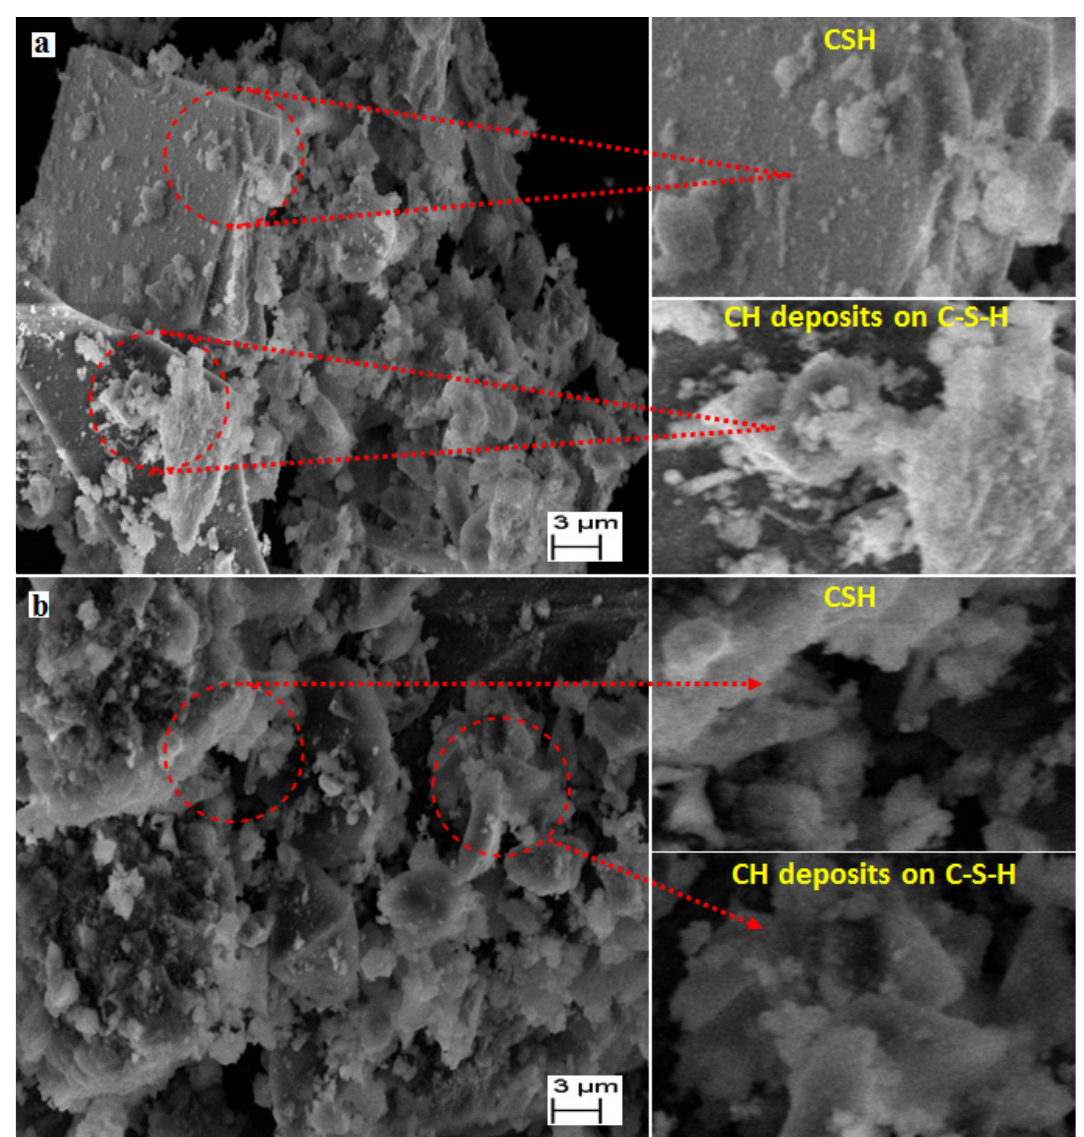
Figure 12. SEM micrograph of calcium hydroxide (Ca(OH) 2 ) crystals in cement paste prepared with ( a ) NWC and ( b ) MWC.